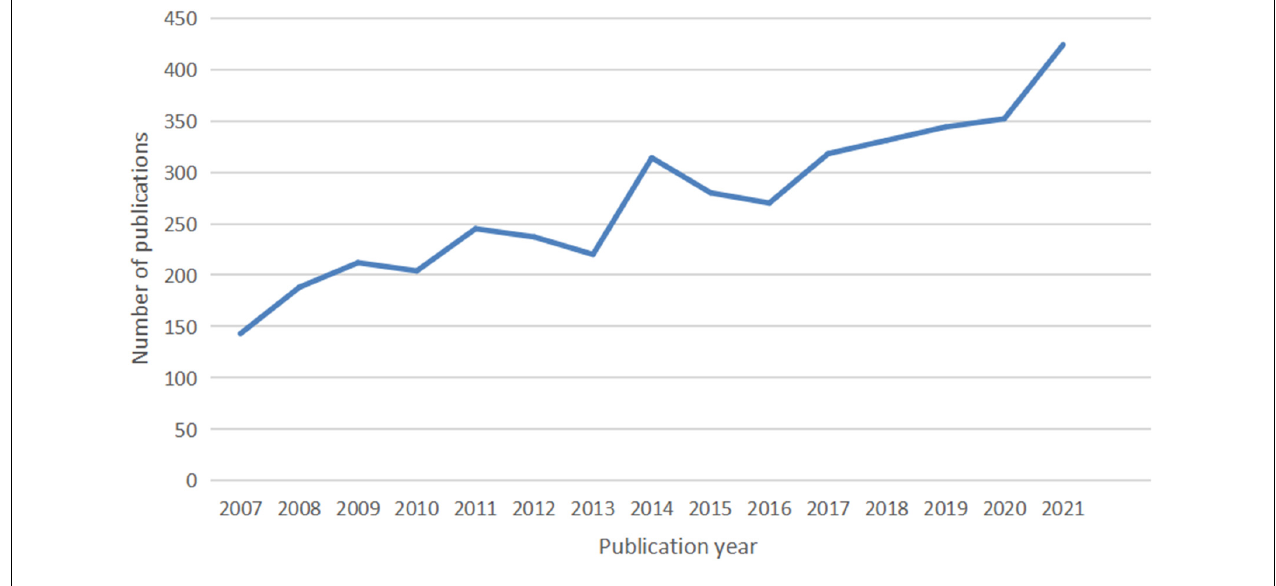
FIGURE 1 | The number of articles published annually in IBS research. TABLE 1 | The top 10 countries or regions and institutions involved in IBS